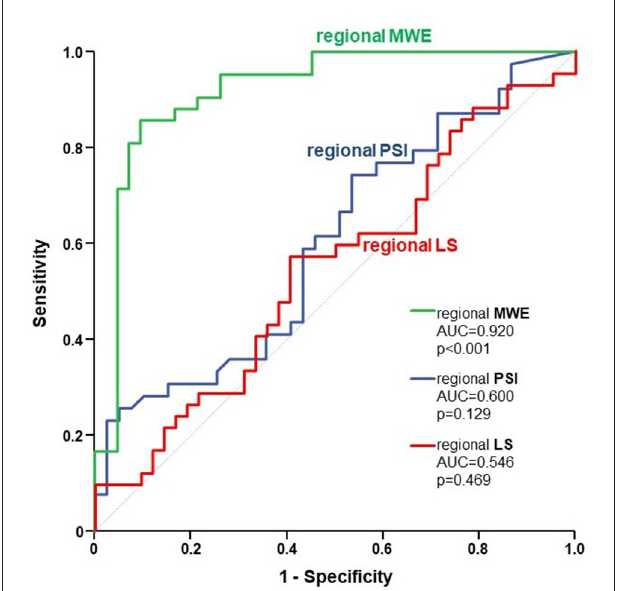
FIGURE 4 | The figure depicts the ROC curves for regional MWE (green), regional PSI (blue), and regional LS (red), reflecting their respective diagnostic performance to predict CAST. ROC, receiver operating characteristic; MWE, Myocardial Work Efficiency; PSI, post-systolic shortening index; LS, Longitudinal Strain; CAST, critical coronary stenosis.